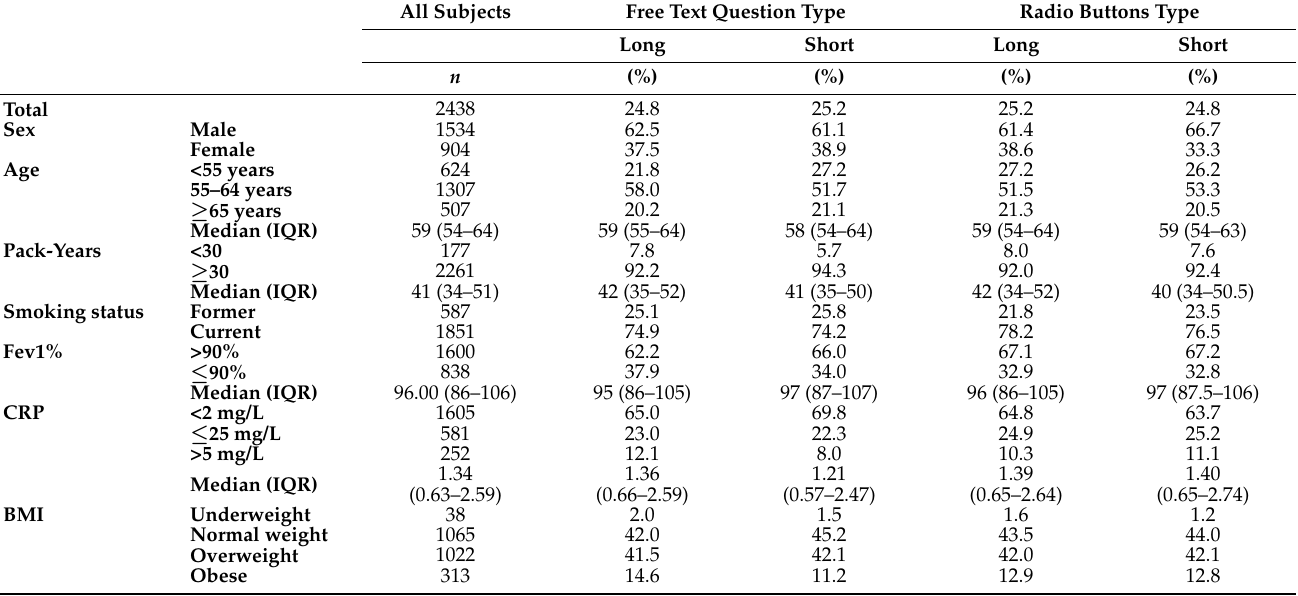
Table 1. Baseline selected characteristics of 2438 participants according to the questionnaire’s